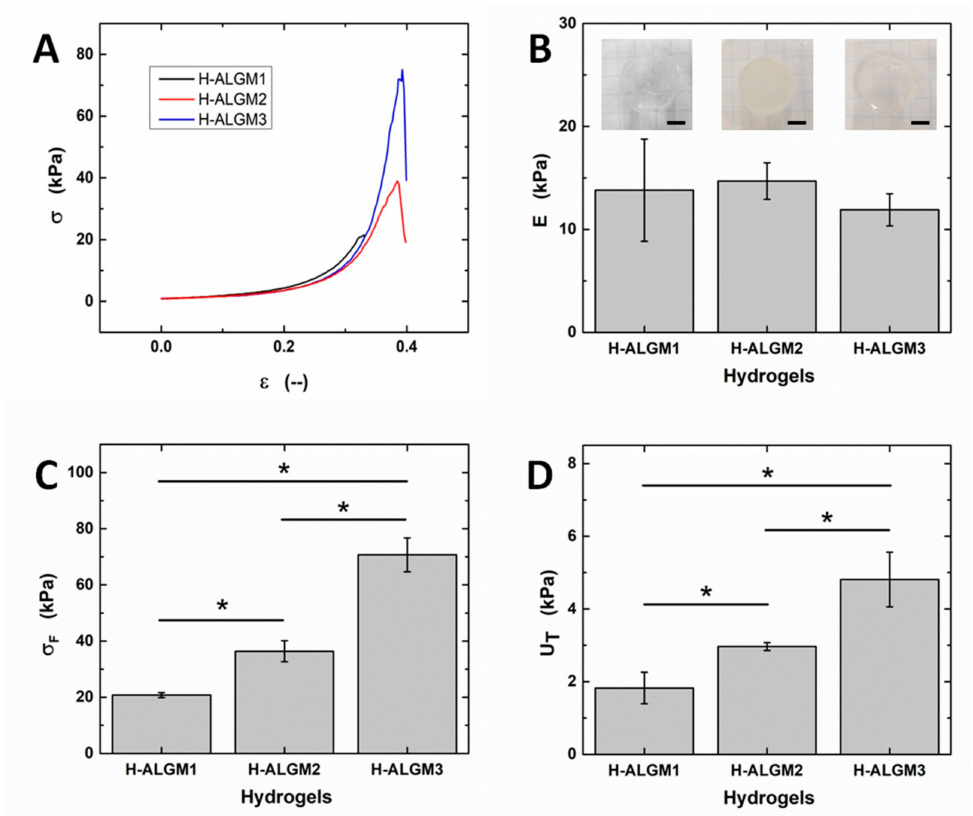
Figure 5. Mechanical properties of H-ALGMx hydrogels: ( A ) Compressive stress-strain curves, ( B ) Young moduli, ( C ) compressive strength, and ( D ) toughness moduli. Insets in ( B ) show representative photographs of each hydrogel, wherein the scale bars stand for 1 cm. As observed from the insets, H-ALGM1 and H-ALGM3 turned out to be transparent, while H-ALGM2 was found to be opaque. (Note the squared pattern beneath each hydrogel to appreciate its transparency or